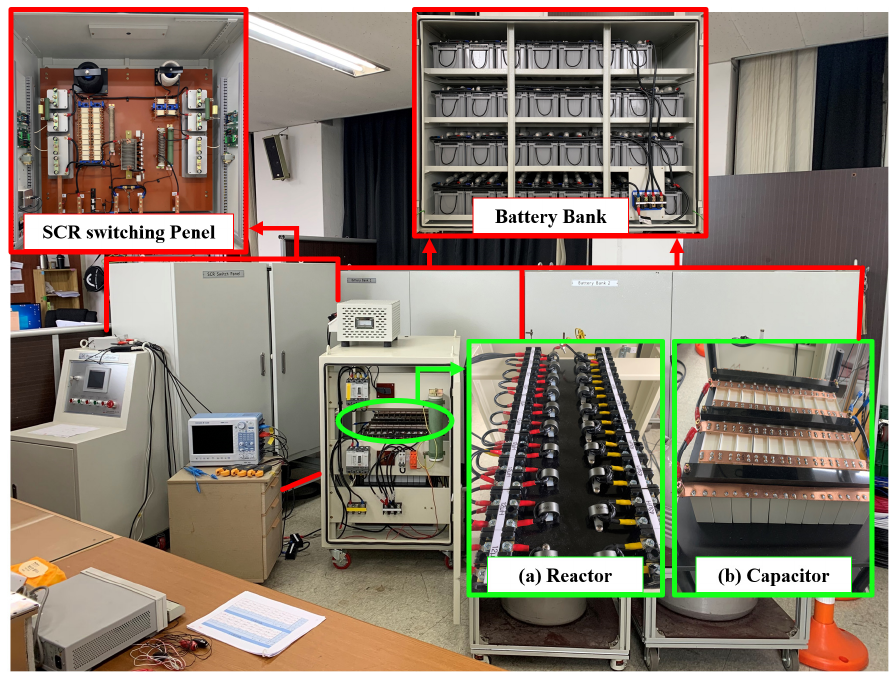
Figure 4. Test bed in the lab with the LC divergence oscillation circuit configured in Reactor and